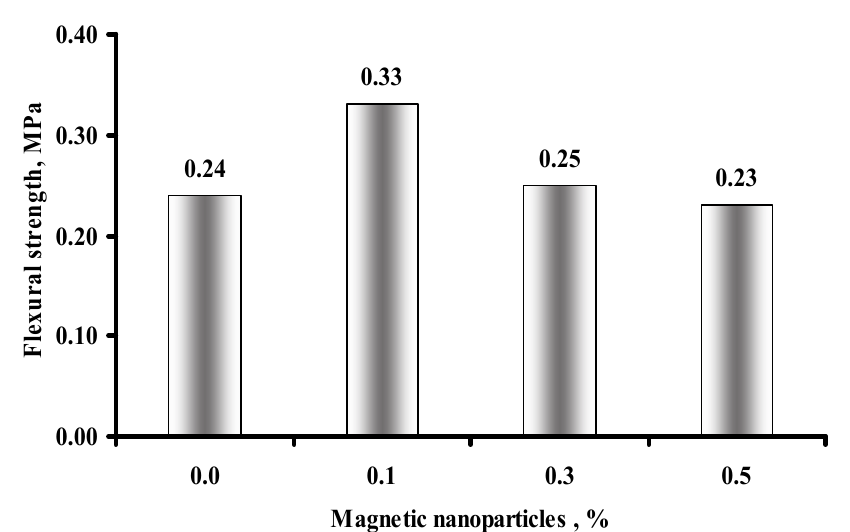
Figure 7. Flexural strength of magnetic composites in dependence on the filler content in %.